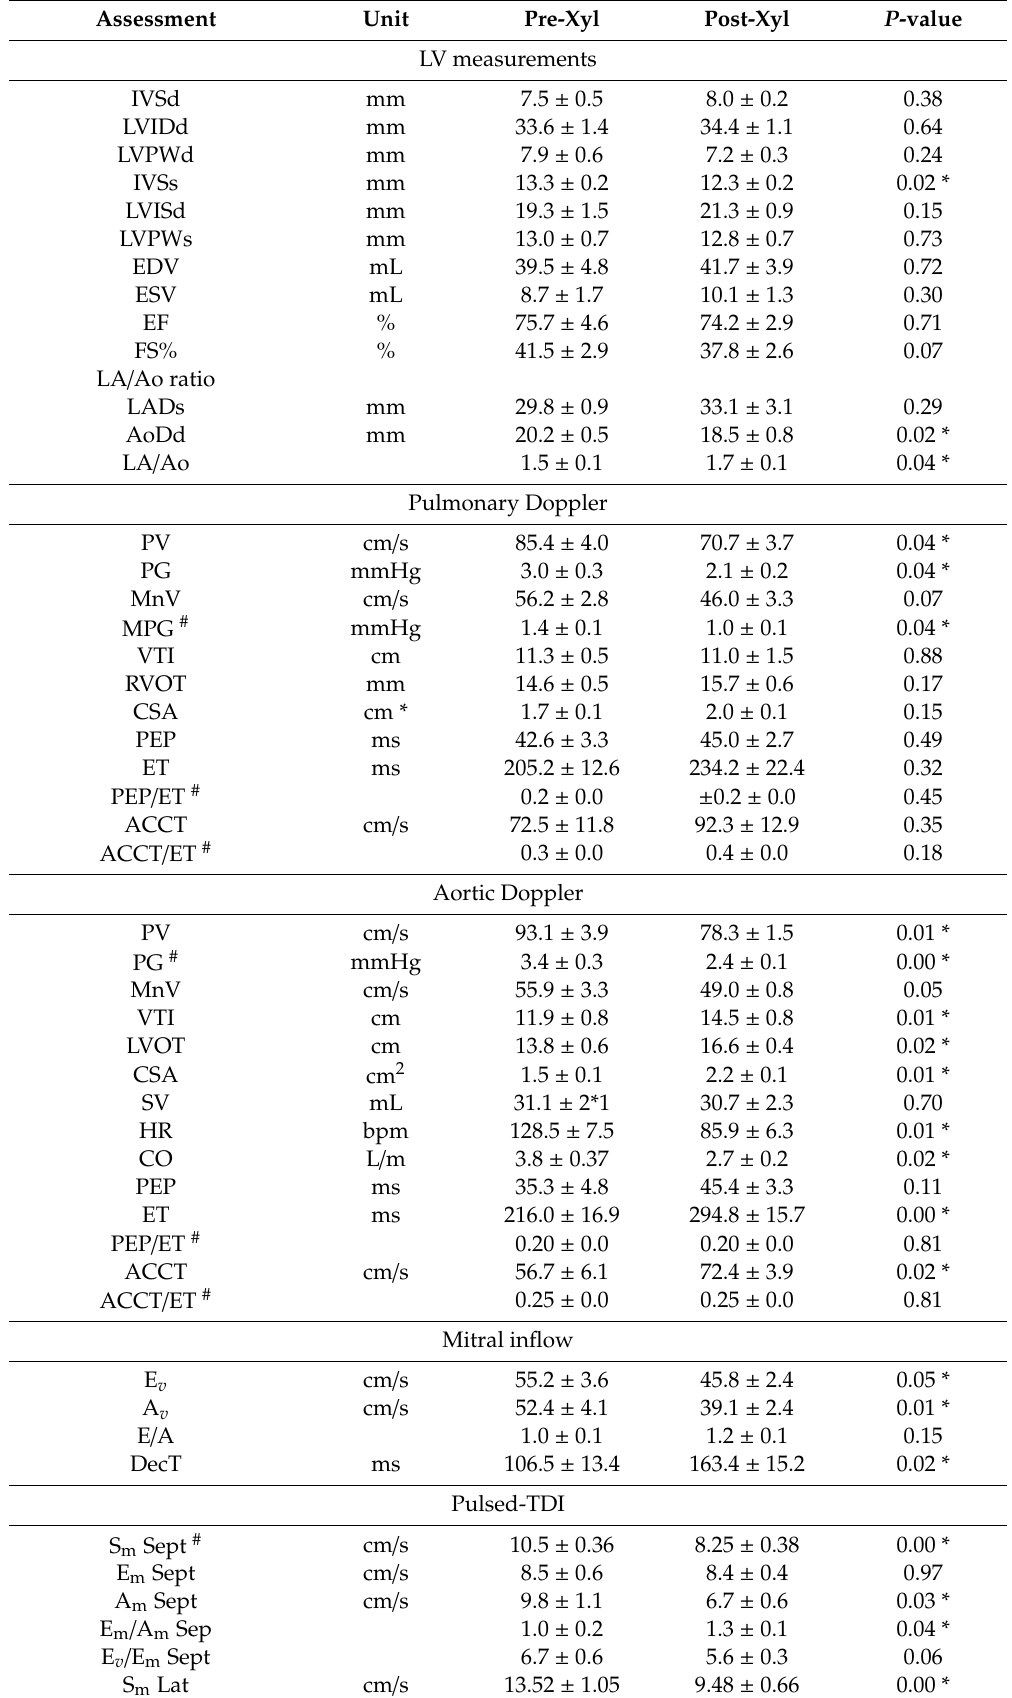
Table 2. Two-dimensional, pulsed-wave Doppler, and tissue Doppler imaging echocardiography measurements before and after xylazine administration in male Shiba